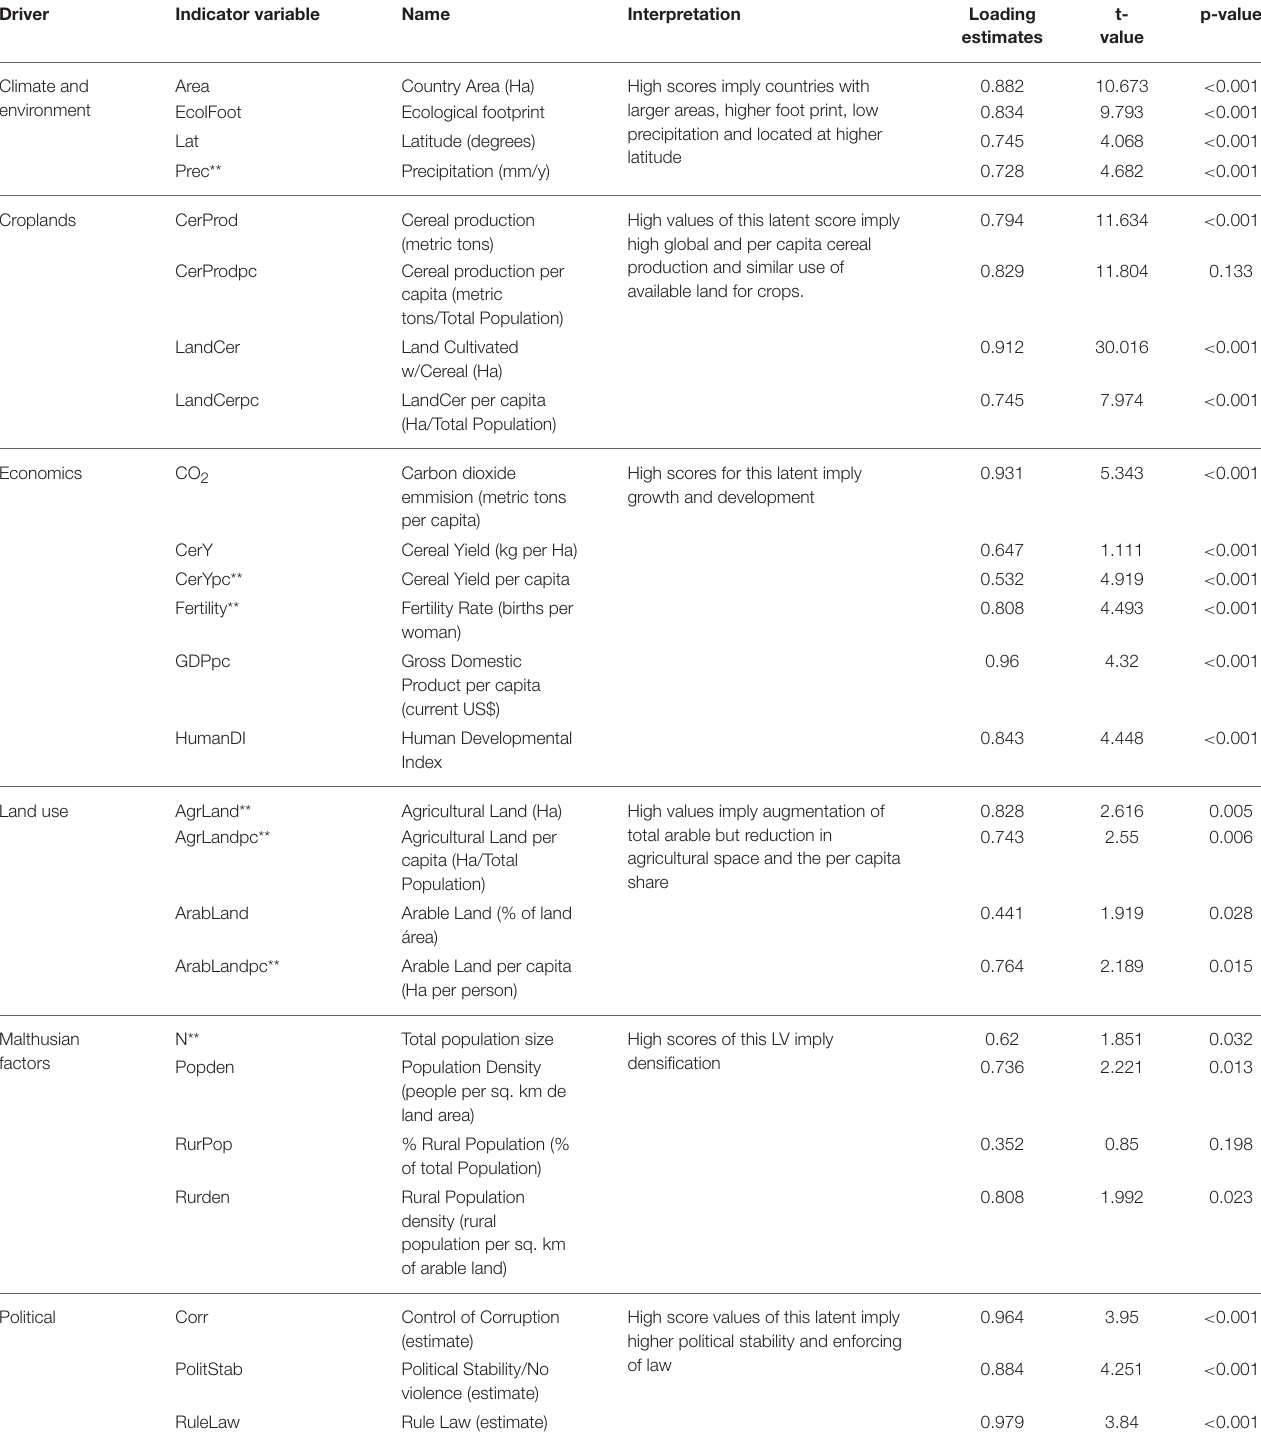
TABLE 1 | Latent and indicator variable relations; all indicators were considered reflective.